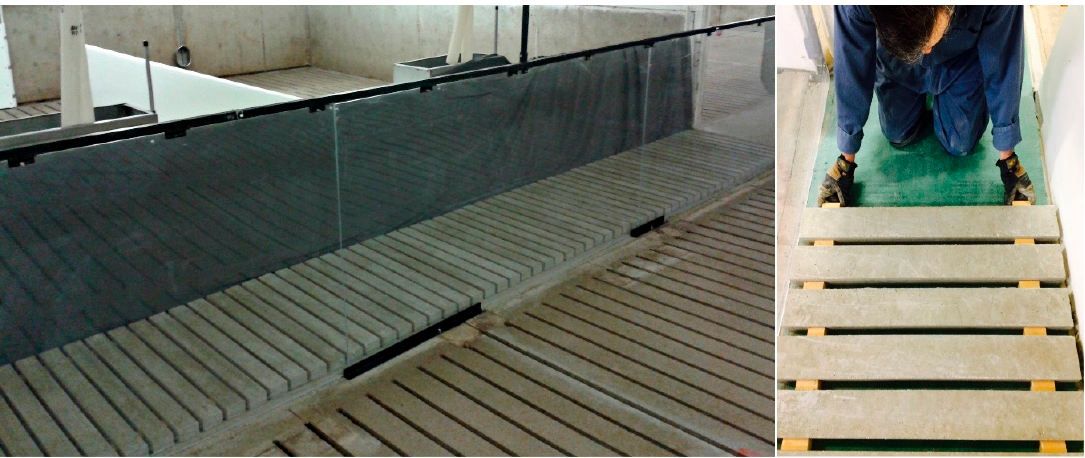
Figure 1. Set-up of corridor for kinematics measurement.